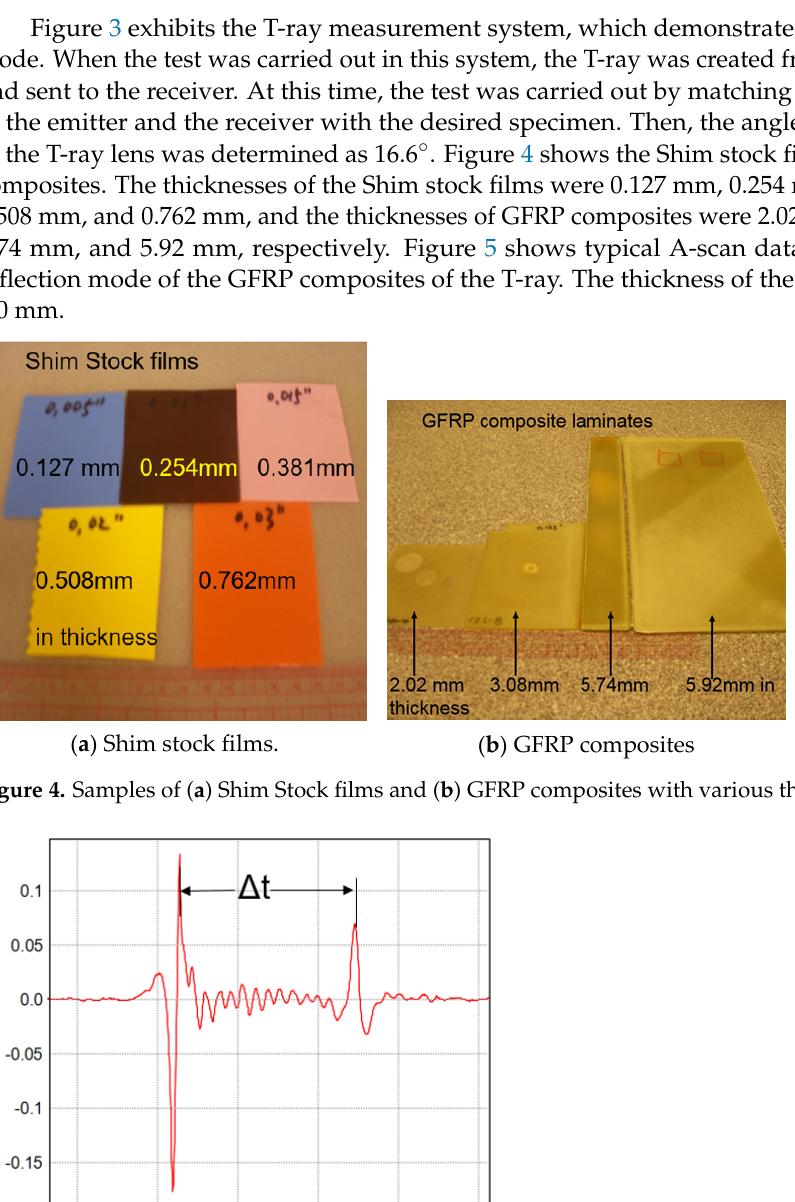
Figure 3. Overview of the THz measurement method [2].